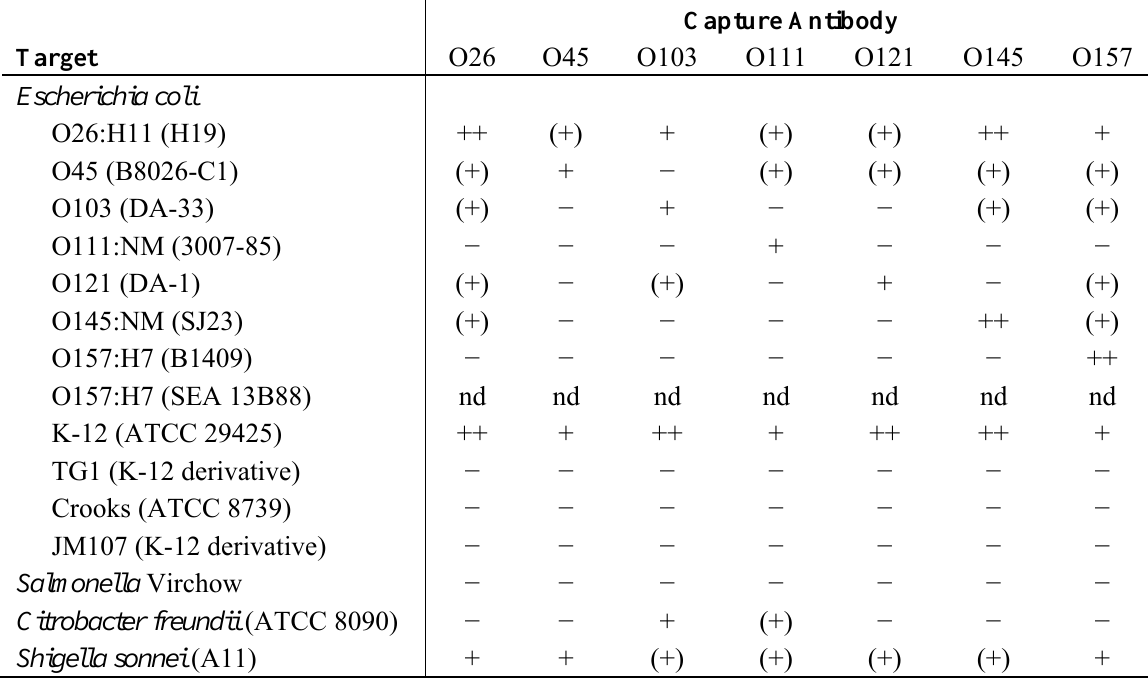
Table 2. Semi-quantitative microarray responses for target and non-target bacterial samples ( ca. 1 × 10 8 CFU/mL) reacted with low dilutions (1:10 to 1:30) of PSU purified IgGs. (Key: − = no binding; (+) = faint binding; + = binding; ++ = high binding, nd = not determined).